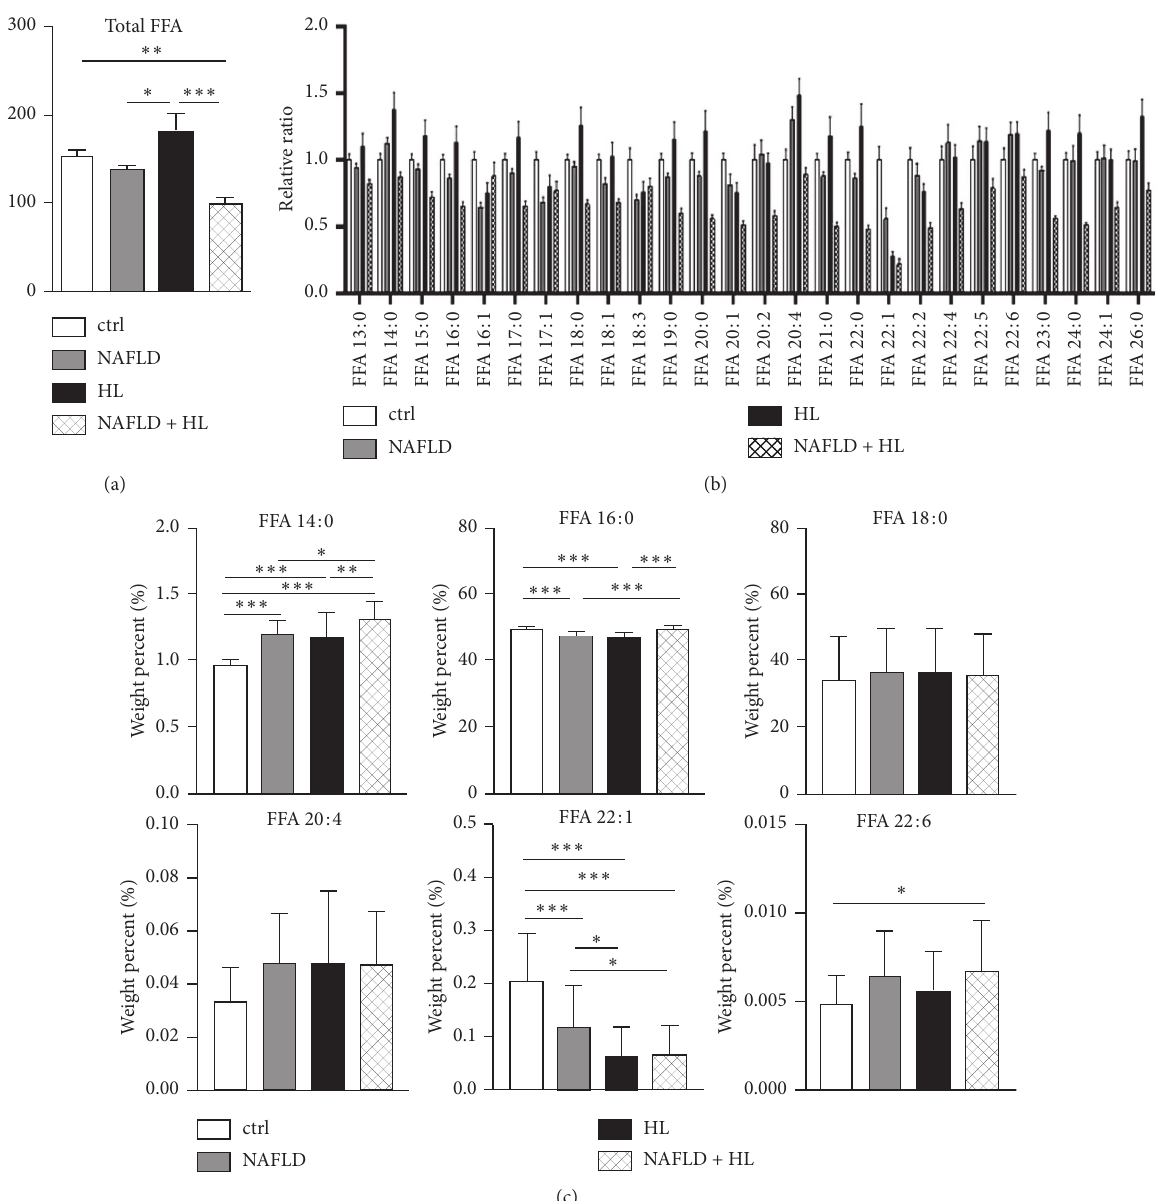
Figure 1: The contents of total FFA (a), relative ratio of individual FFA (b), and weight percentage (%) of six FFAs (c) in the erythrocyte membrane. Error bars represent the mean ± SD; ∗ p < 0 . 05, ∗∗ p < 0 . 01, ∗∗∗ p < 0 .